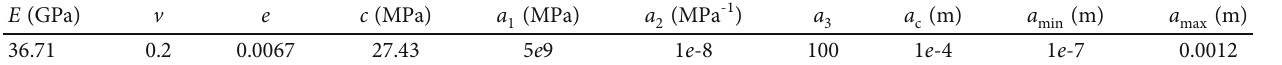
Table 1: The calculation